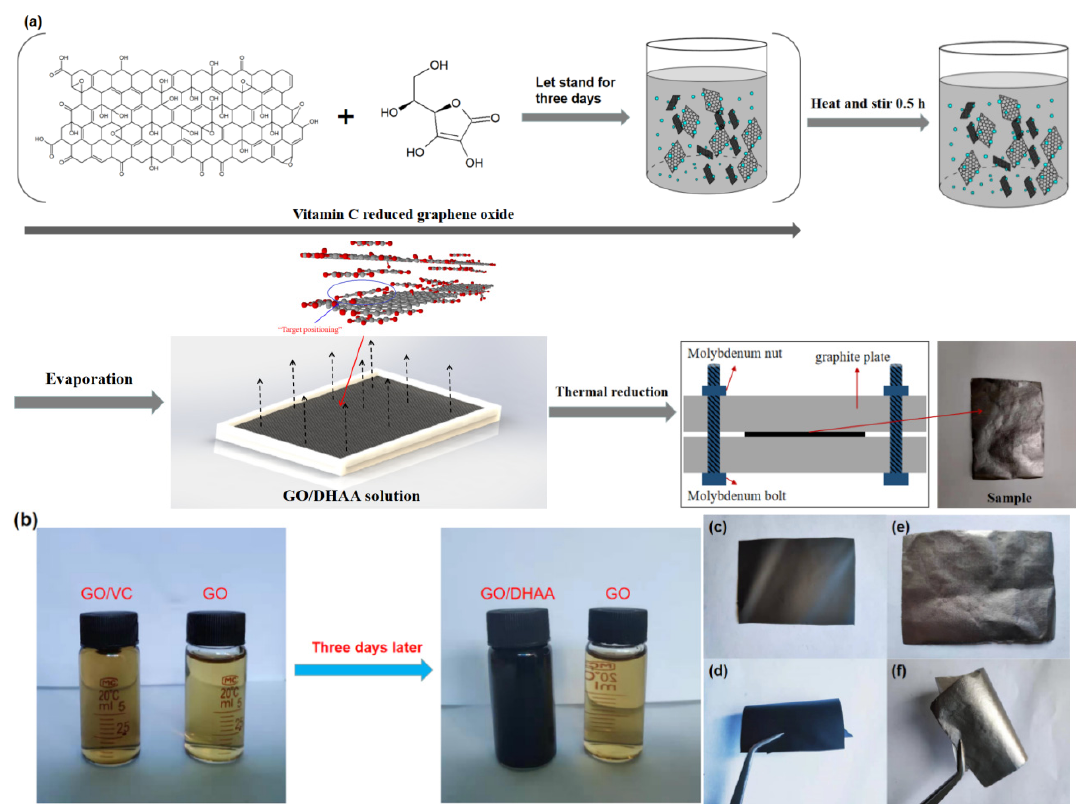
Figure 1. ( a ) Flow chart of the rGO/VC (reduced graphene oxide was added with vitamin C) film preparation by solvent evaporation; ( b ) before and after chemical reduction of vitamin C for GO; ( c , d ) optical photo of GO/VC; ( e , f ) rGO/VC-15% optical photo.